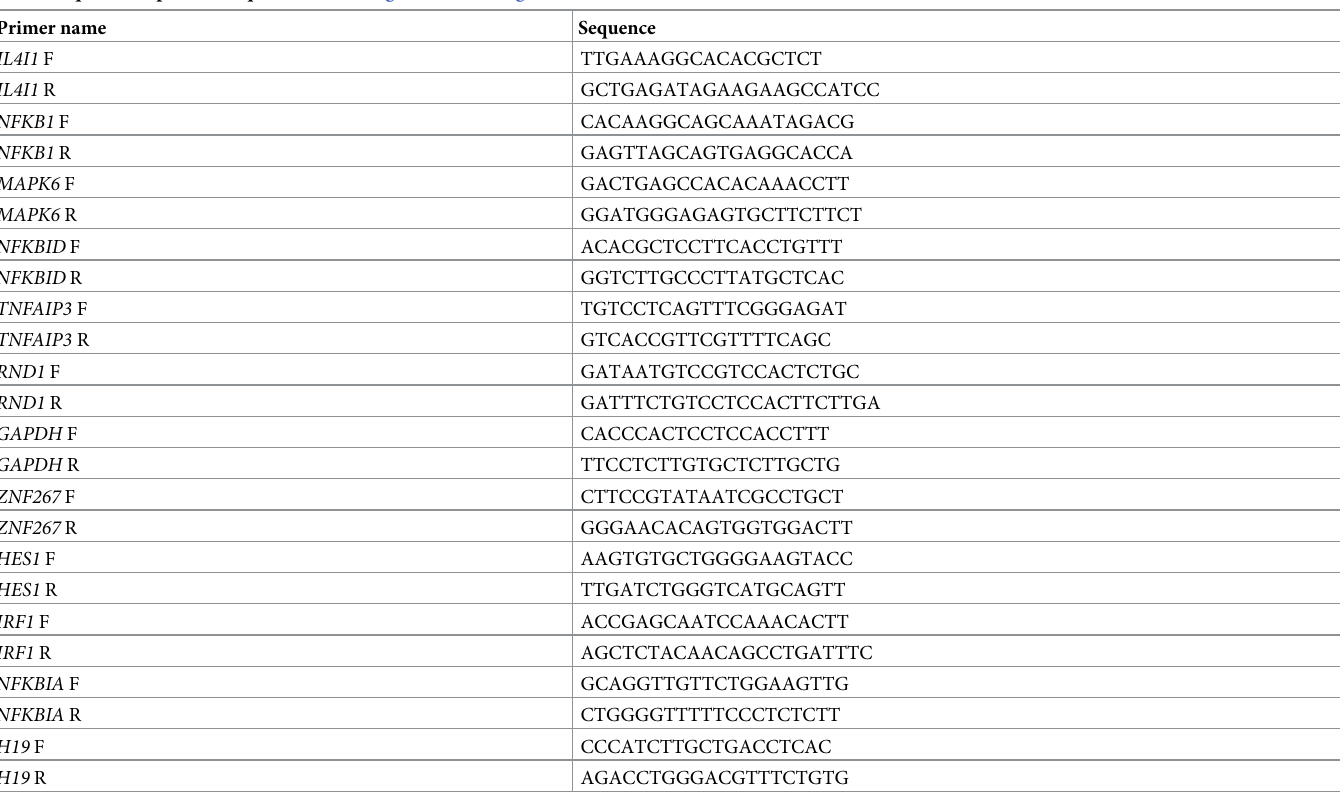
Table 1. qRT-PCR primers sequence used in Fig 3A and S3E